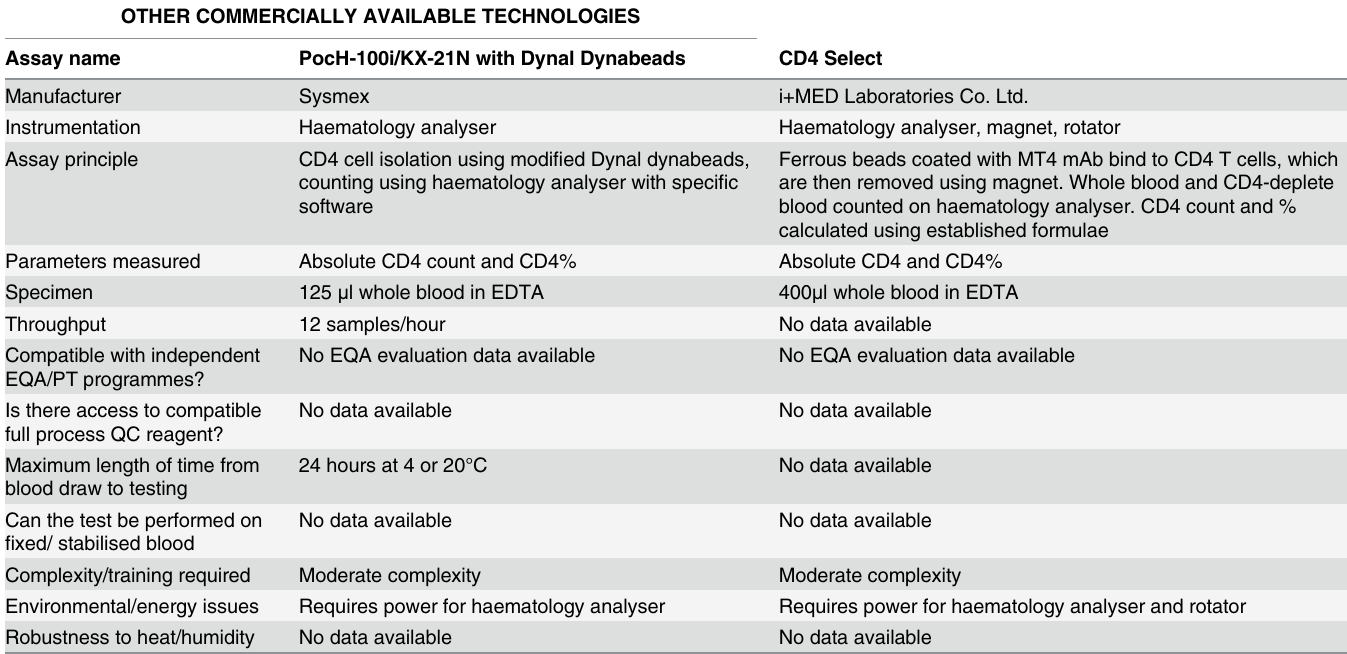
Table 4. Operating characteristics of other commercially available technologies for CD4+ T-cell